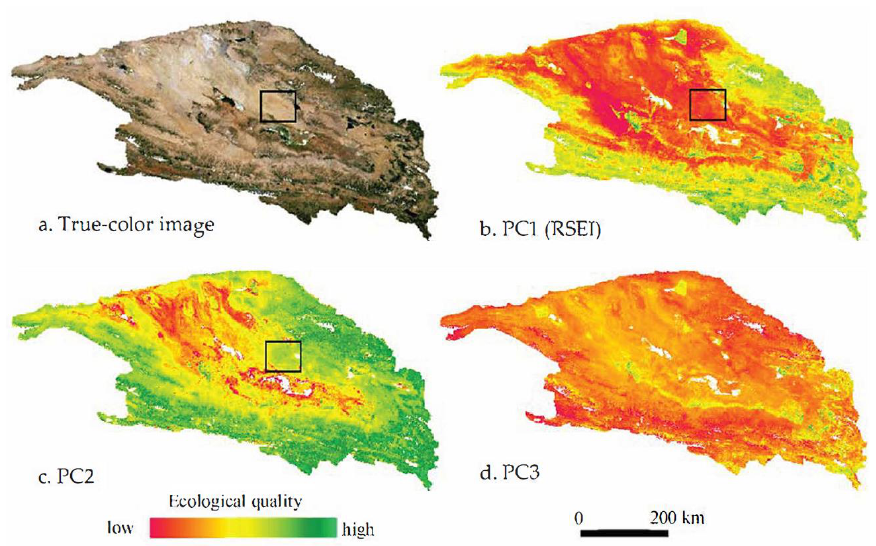
Figure 2. The true-color image ( a ) of the Caidam Basin, and the PC1, PC2, and PC3 images ( b – d ) derived from four indicators. The box area shows that a bare desert area in the true color image appears as a low ecological quality (red) area in the PC1 image, but presents mistakenly as a high ecological quality (green) area in the PC2 image.